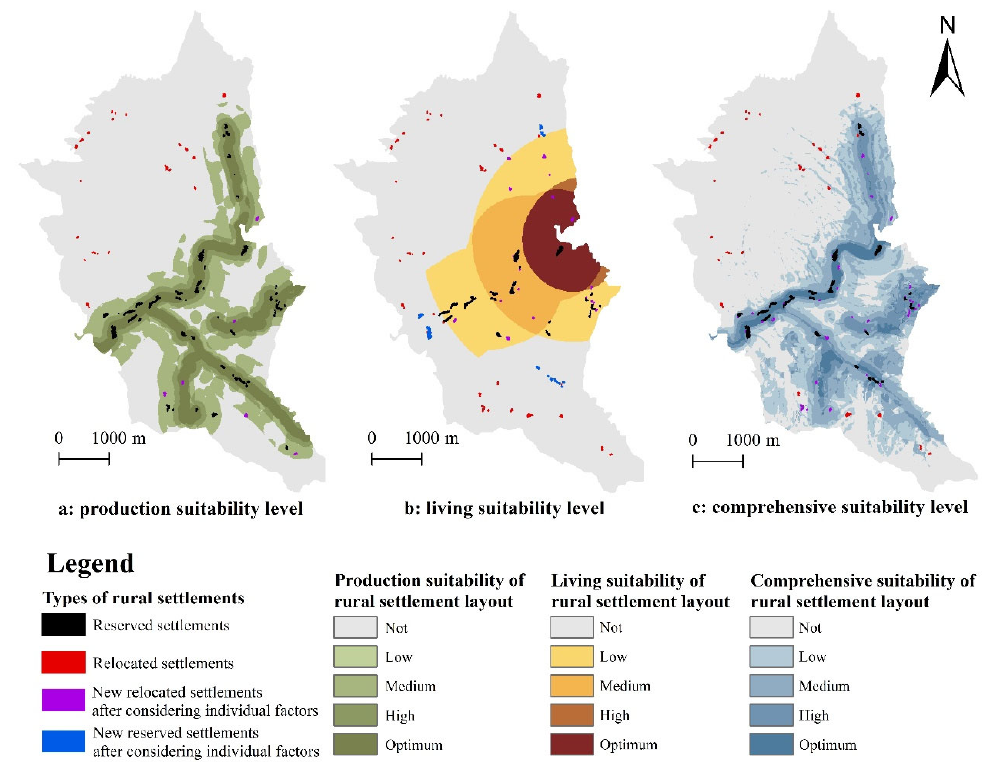
Figure 5. Influence of individual factors on rural settlement reconstruction.